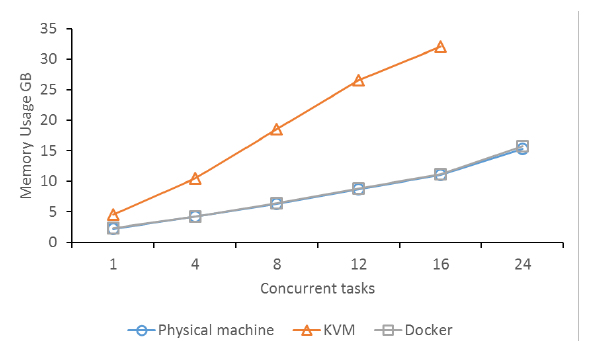
Figure 9. Host memory usage of different concurrent tasks